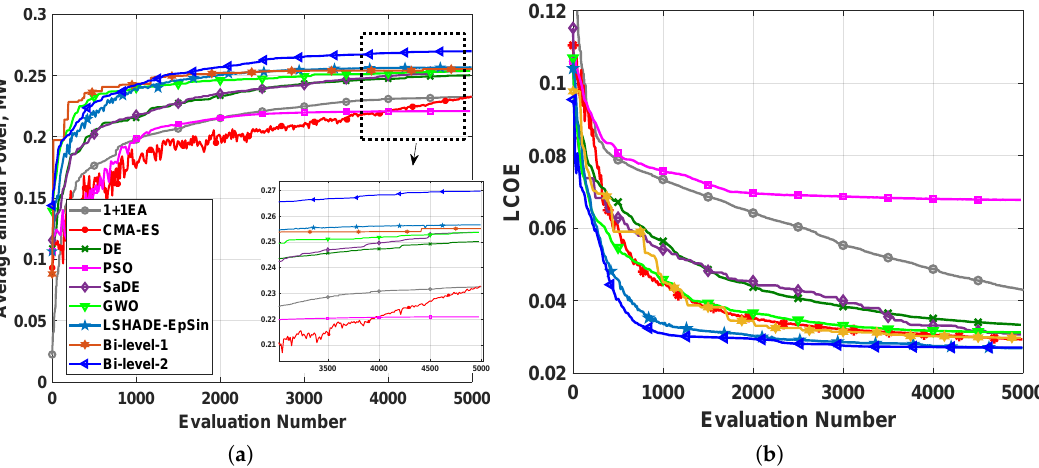
Figure 10. The average convergence rate comparison of the absorbed power and LCoE of the cylinder. Each method runs 10 times. ( a ) Average annual produced power, ( b ) Levelised cost of energy